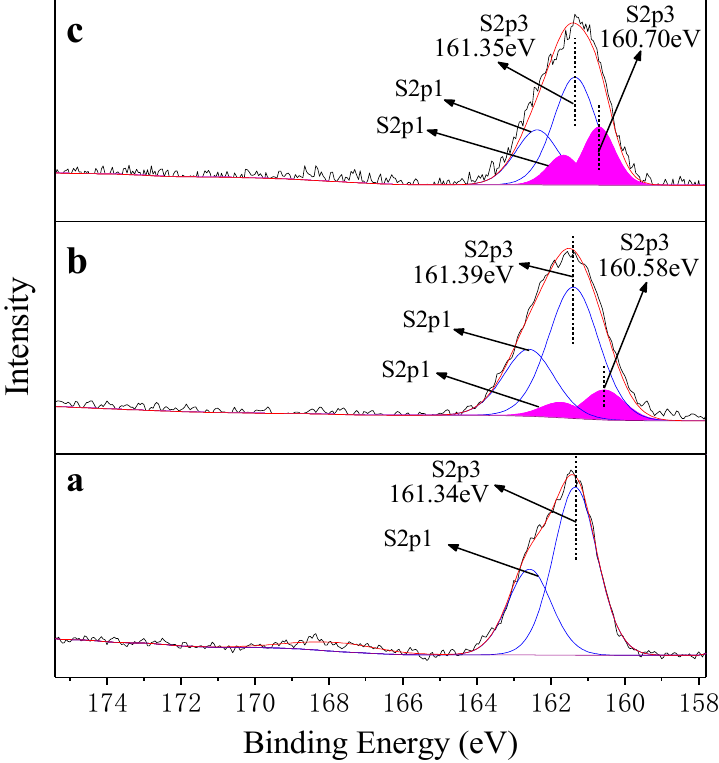
Figure 8. X-ray photoelectron spectra (s 2 p) for ( a ) hemimorphite + Na 2 S, ( b ) hemimorphite + Na 2 S + Pb 2+ , and ( c ) hemimorphite Pb 2+ + Na 2 S + Pb 2+ .